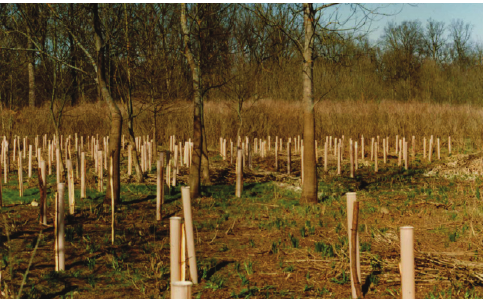
FIGURE 1. An experimental plot with polypro- pylene tree shelters (Forest Office Kutina, Kutina Lowland Forests management unit, June